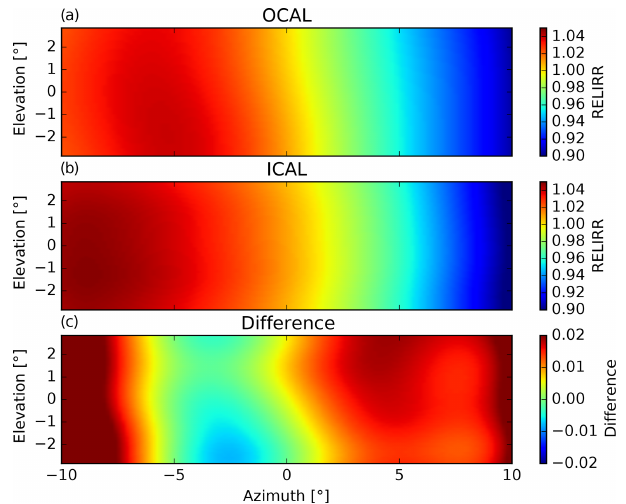
Figure 11. The CKD for band 3 for diffuser QVD1 as derived from the on-ground campaign data (a) ; the CKD derived from commissioning-phase data (b) ; and the difference between the two (c) . Shown is the value for a super pixel in the corner of the detector in row 20 and column 30. The in-flight CKD show more detail, and the in-flight and on-ground CKD differ by up to 2 per- centage